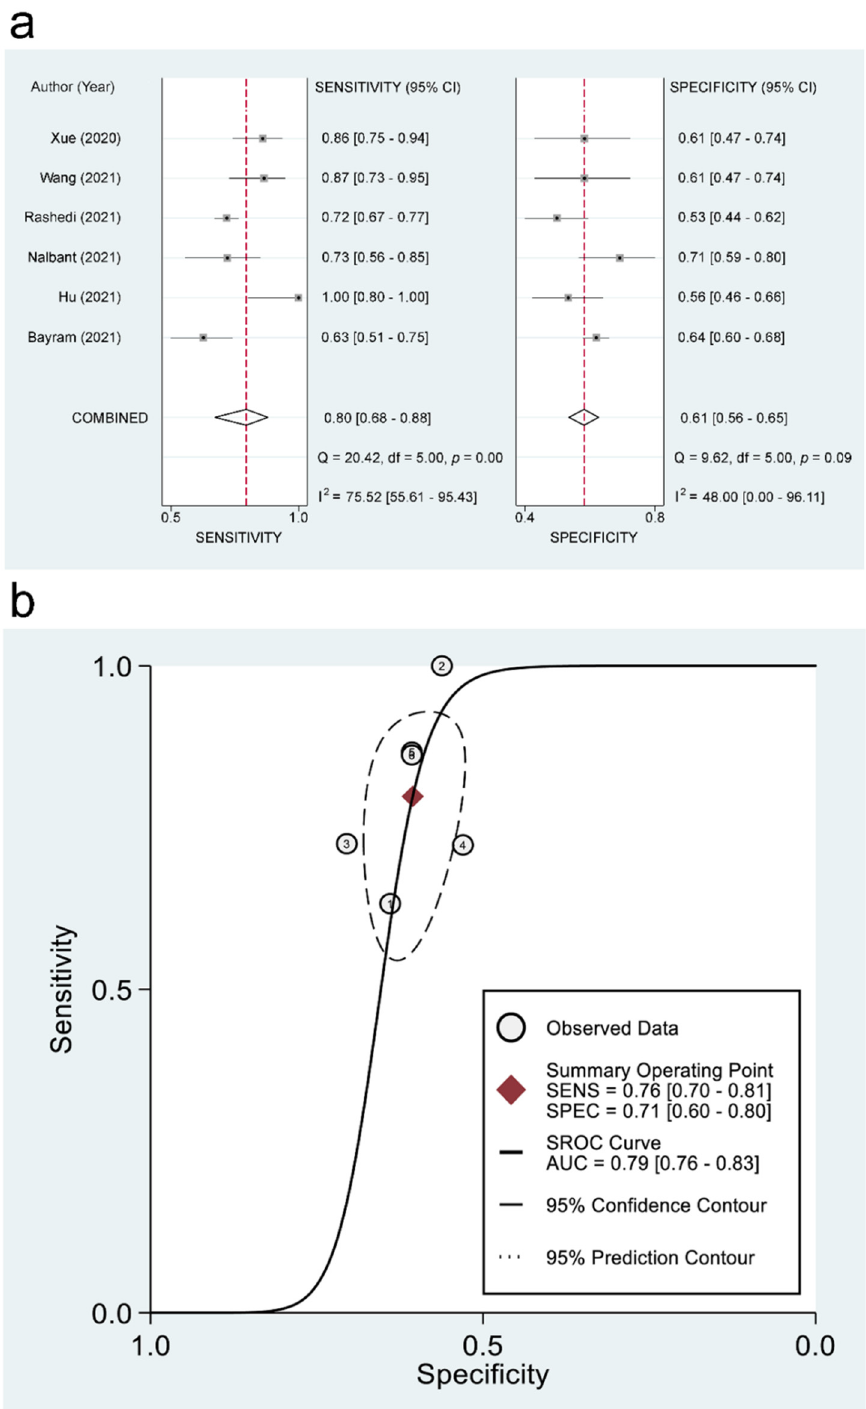
Figure 6. ( a ) Forest plots comparing the sensitivity and specificity of applying prognostic nutritional index (PNI) to the prediction of disease severity in patients with COVID-19 across the included studies [19,30,31,33,35,36], and ( b ) hierarchical summary receiver operating characteristic (hsROC) curves of using PNI for predicting disease severity in patients with COVID-19. SENS: Sensitivity, SPEC: Specificity, SROC: Summary receiver operating characteristic, and AUC: Area under the curve.